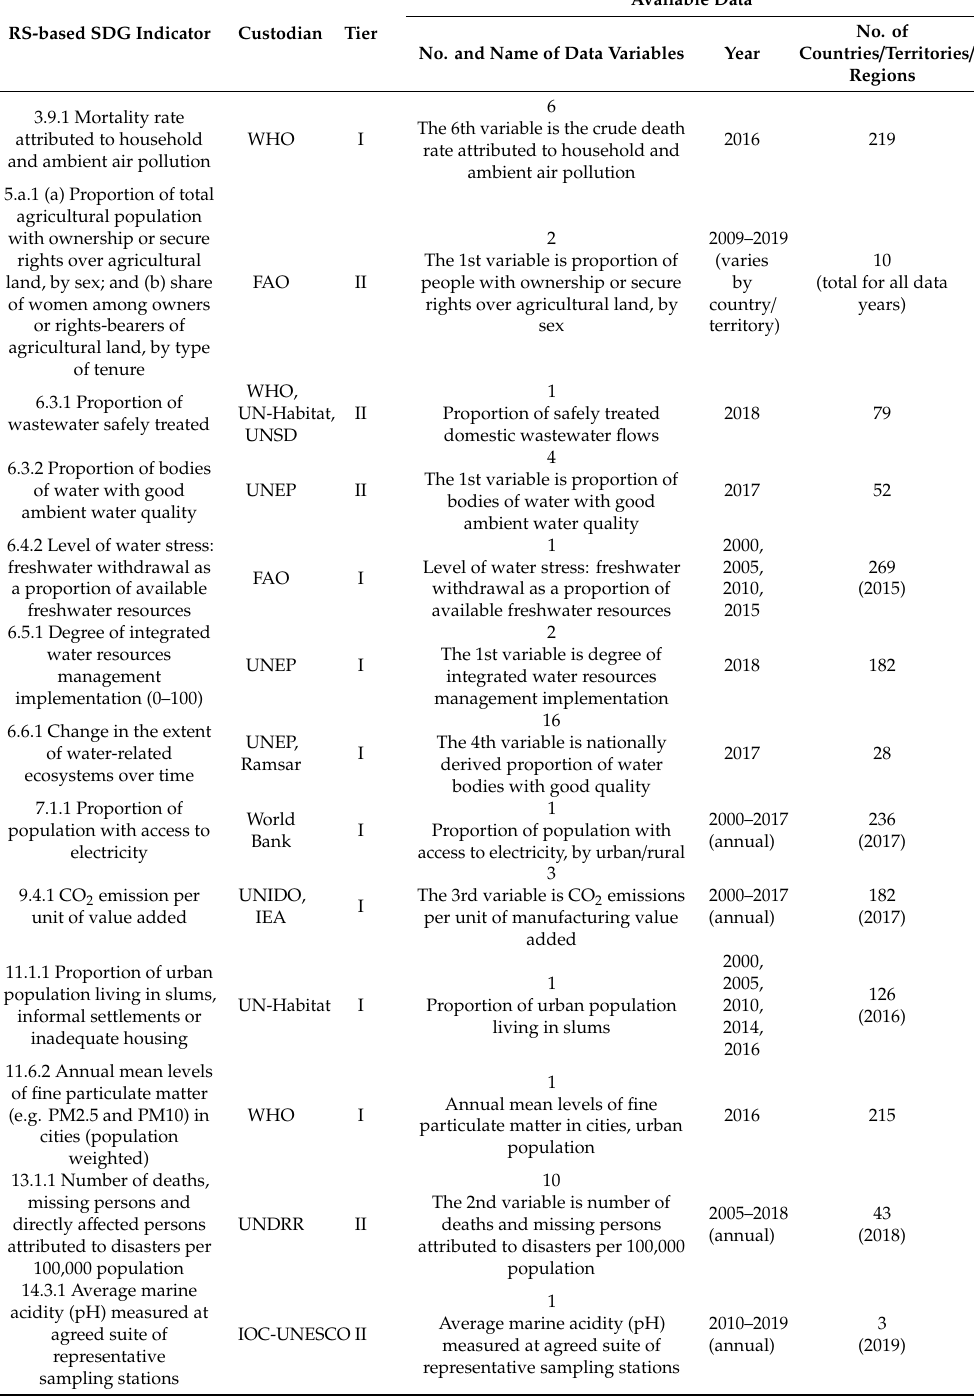
Table 1. Status of remote sensing (RS)-based sustainable development goals (SDG) indicators. Only those indicators with data as of April 2020, according to the Global SDG Indicators Database (https: // unstats.un.org / sdgs / indicators / database / ), are included. The complete list of RS-based SDG indicators is given in Figure 3. The custodian and tier classification information is current as of April 2020 [20]. The number of countries / territories / regions is for the described variable